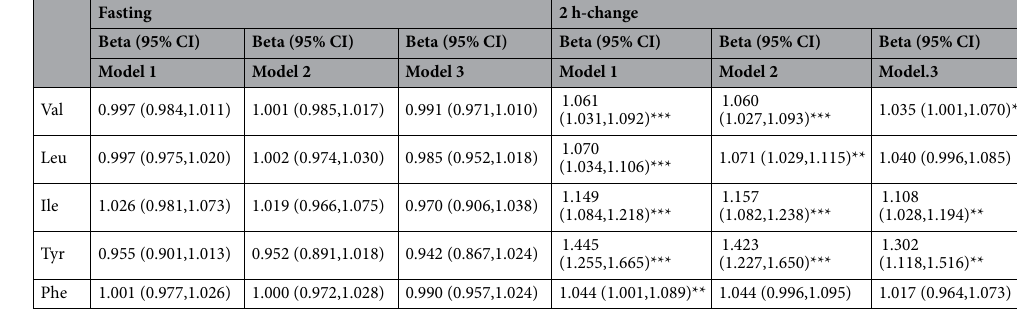
Table 3. The cruel and adjusted logistic regression model of amino acids with gestational diabetes mellitus. Results are based on analyses of the study population [43 women with gestational diabetes mellitus (GDM) and 67 women without GDM (non-GDM)]. Values represent regression coefficients from the logistic regression analyses and their 95% confidence intervals (C.I.) for the risk of GDM. The statistically significant difference was defined as P < 0.05. *P < 0.05, **P < 0.01, ***P < 0.001. 2-h changes which were calculated as Concentration at 2-h-Concentration at fasting. Model 1: unadjusted. Model 2: adjusted for age and gestational age. Model 3: adjusted for age, gestational age and